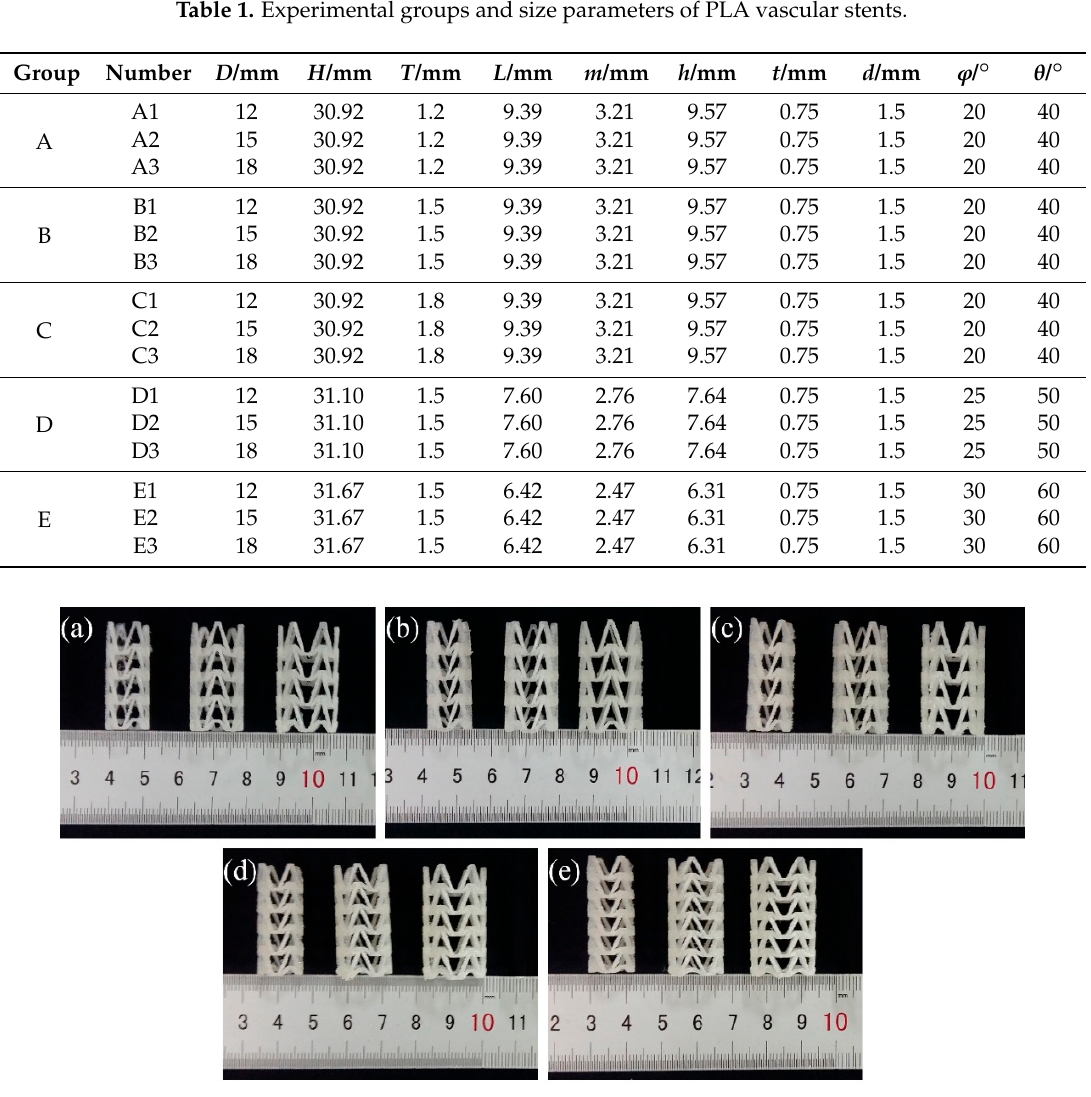
Figure 3. 3D-printed PLA vascular stents, from ( a – e ) are 3D-printed PLA vascular stents of A, B, C, D and E group